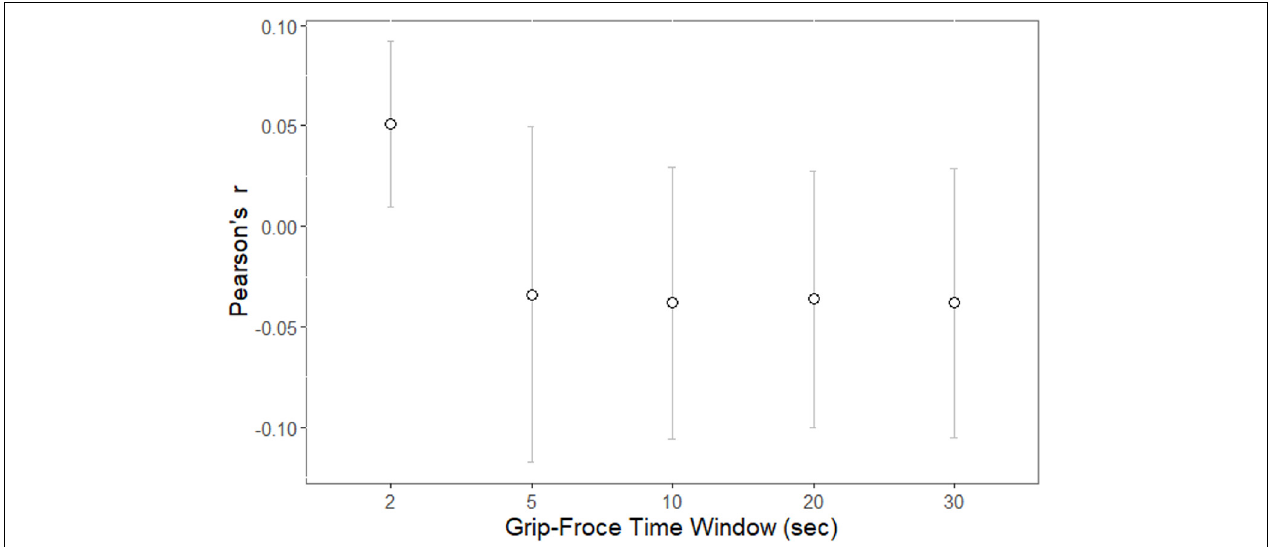
FIGURE A1 | Confidence intervals of the Pearson correlation coefficient ( r ) for meta-analyses of Ln-transformed grip force’s measures (mean, maximum, and standard deviation) with Ln-transformed heart rate measures (HRV LF, HRV HF, HRV LF/HF ratio, and heart rate) for each grip force’s time window (2, 5, 10, 20, and 30